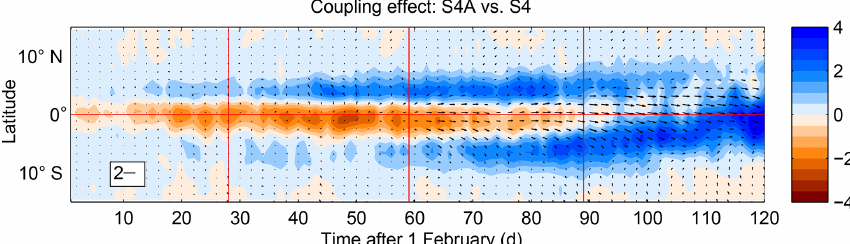
Figure 6. Latitude–time plot, averaged as in Fig. 3, showing the coupling effect on rainfall (filled contours, in mmd − 1 ) and wind vector (in ms − 1